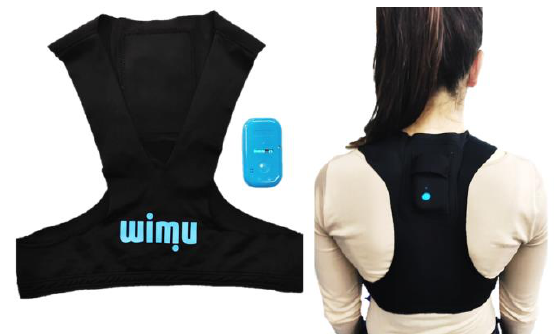
Figure 1. Player wearing the inertial device.